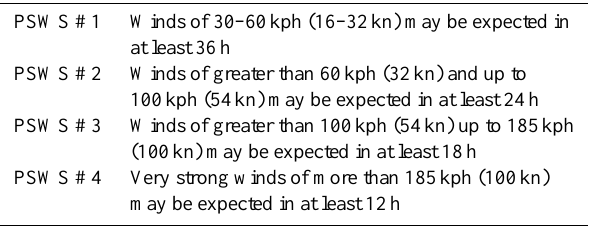
Table 1. Public storm warning signals from